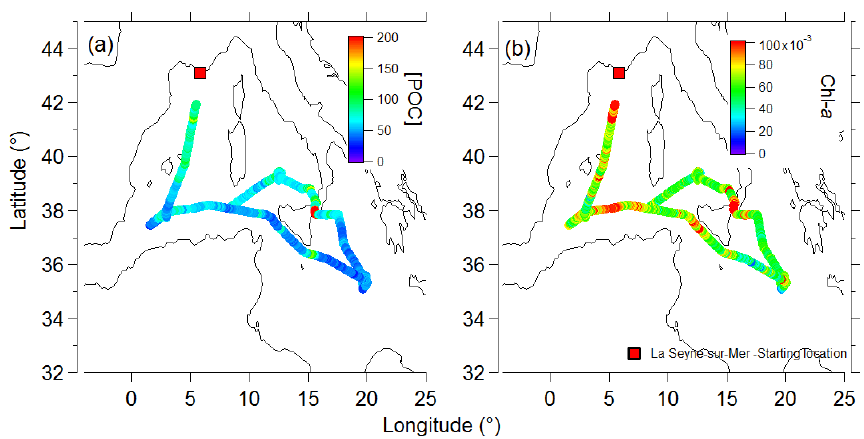
Figure 1. The ship track in the Mediterranean Sea during the PEACETIME expedition. The trajectory is colored by (a) POC and (b) chl a